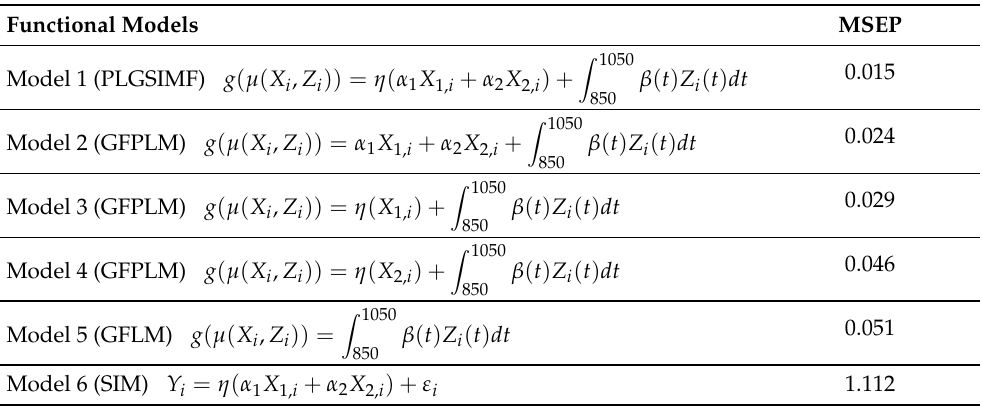
Table 17. The MSEPs for different models.